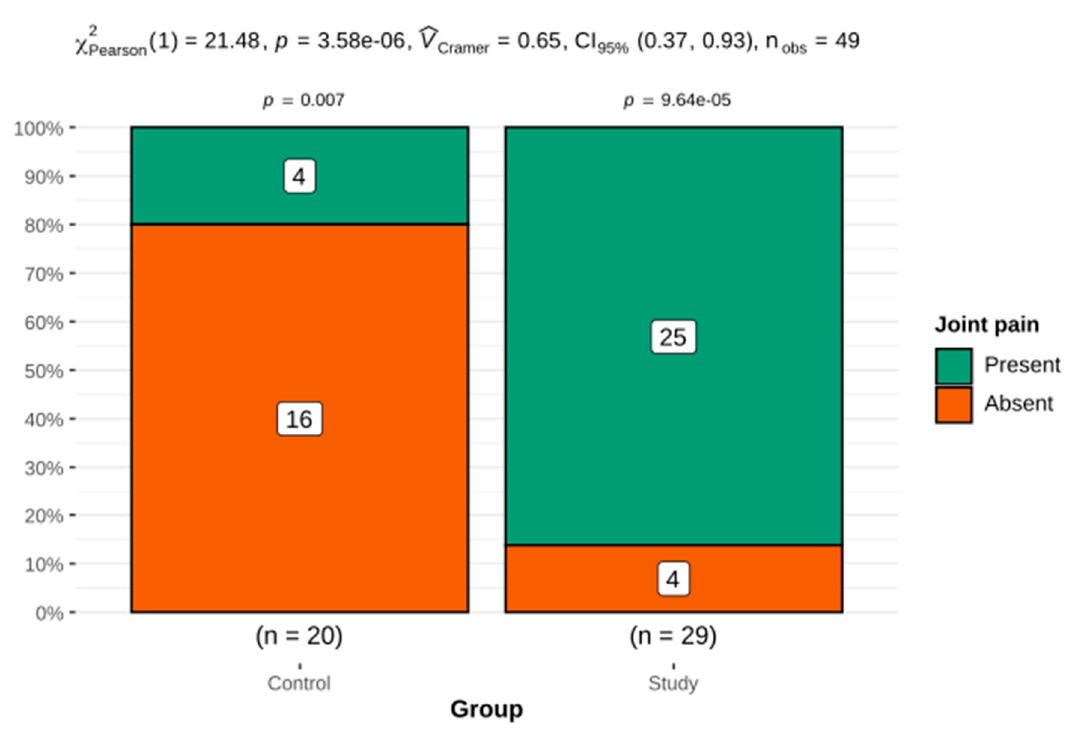
Figure 6. The frequency of joint pain in the HH group compared with the control group.